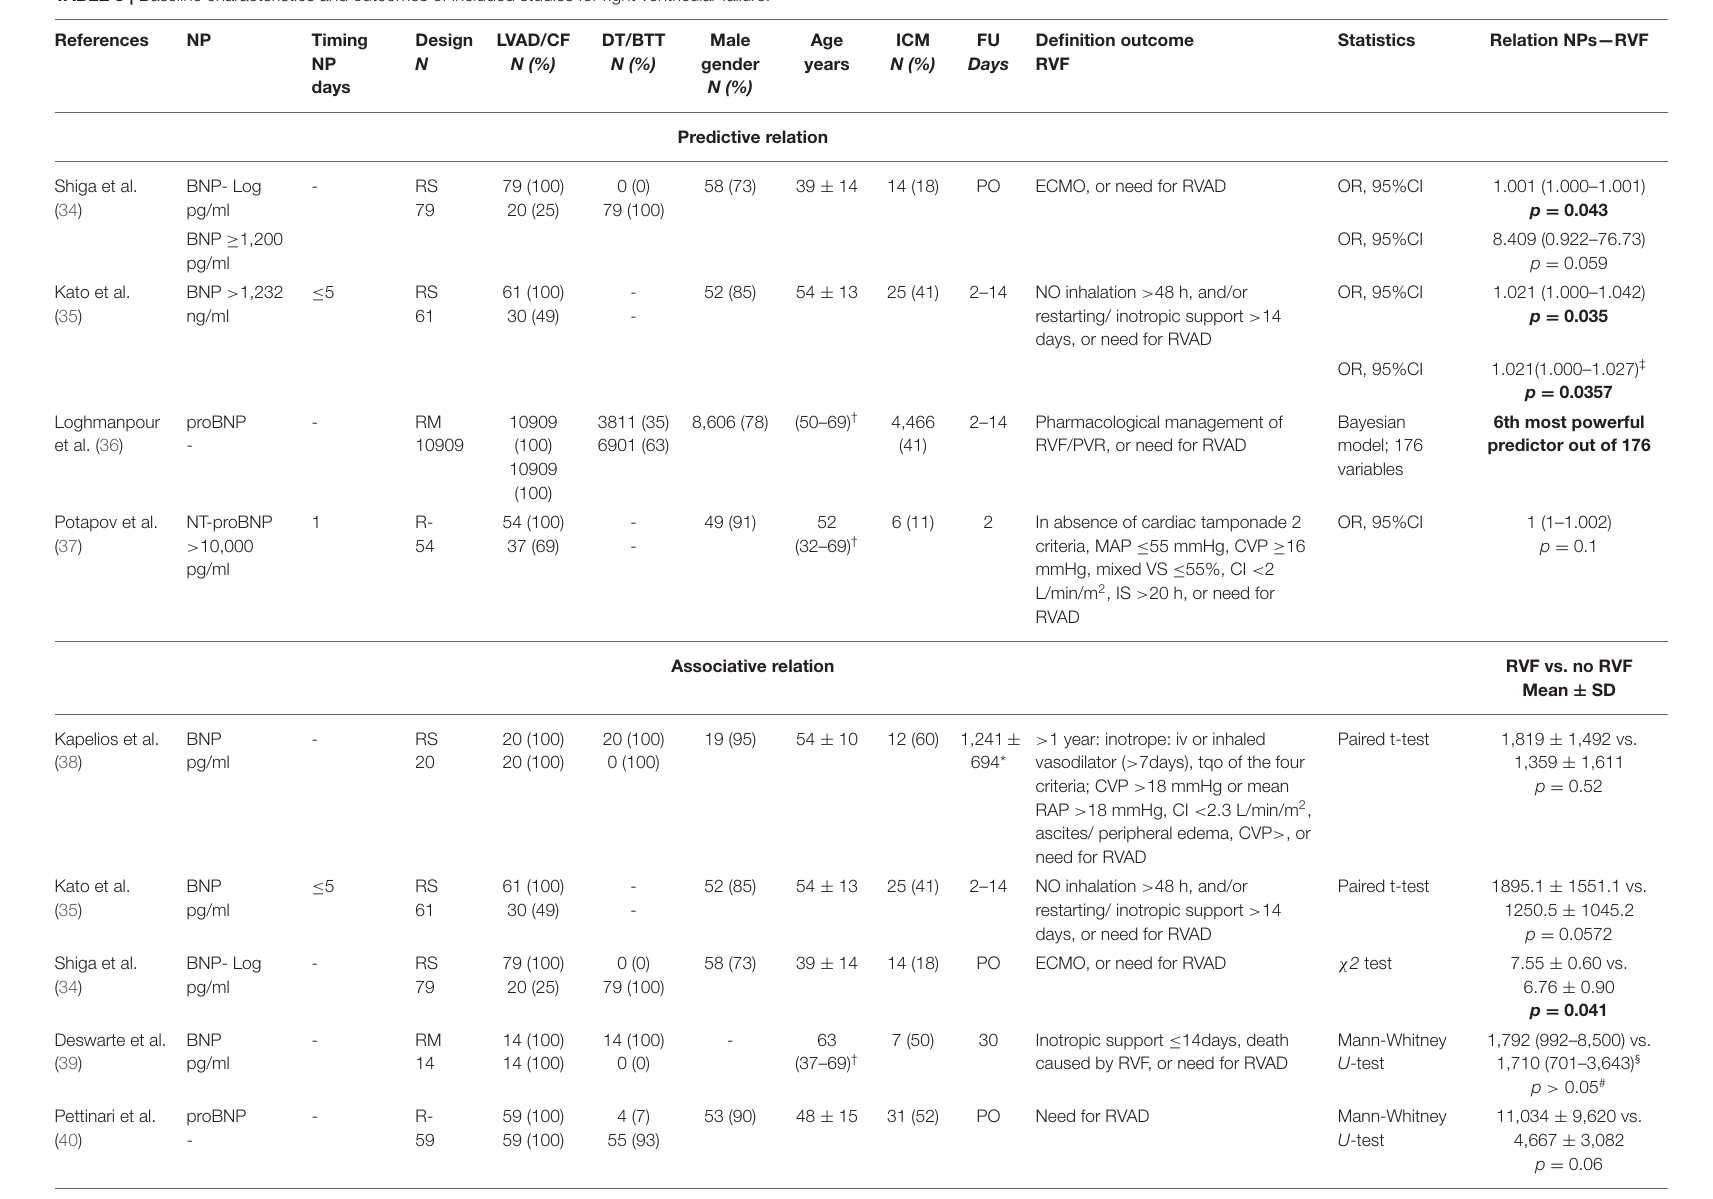
TABLE 3 | Baseline characteristics and outcomes of included studies for right ventricular